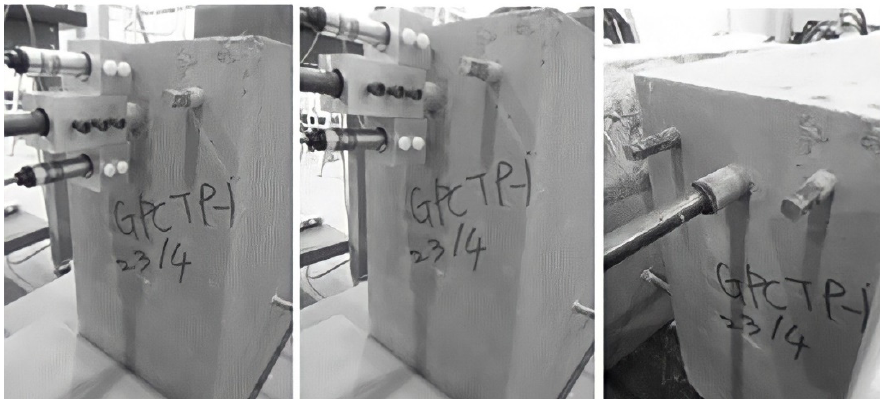
Figure 3. Front face images of plain bar reinforced GPC specimens: photos taken before (left), during (middle) and after (right) the beam end test.